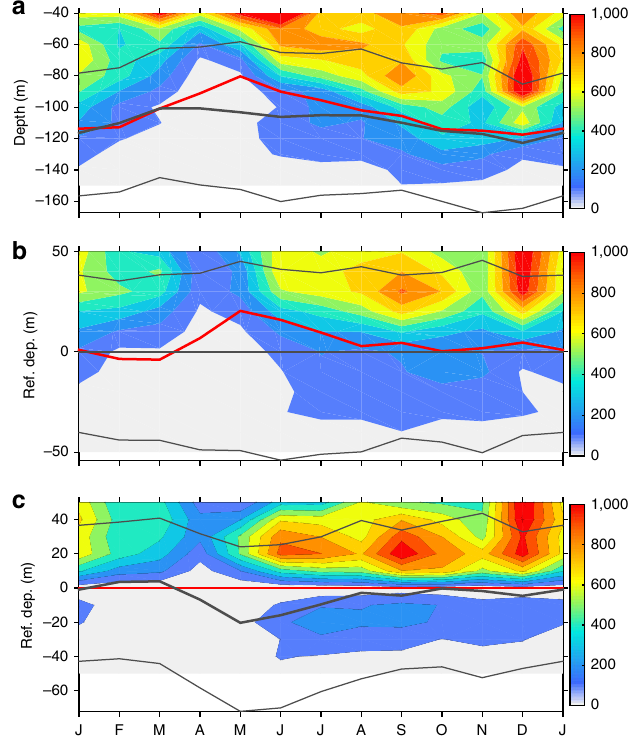
Figure 4 | Monthly climatology of count of critical levels at 140 (cid:2) W of the Equator. ( a ) On physical depths. ( b ) On depths that is referenced to hourly centres of the thermocline (defined as the depth of maximum vertical gradient of 40-m running-averaged temperature). ( c ) On depth that is referenced to hourly centres of the EUC (defined as the depth of maximum eastward velocity). Shown are counts in 10-m bins. In each panel, the red curve denotes the average depth of EUC core, the black thick curve denotes the average depth of the thermocline centre and the two black thin curves denote the average upper and lower bounds of the